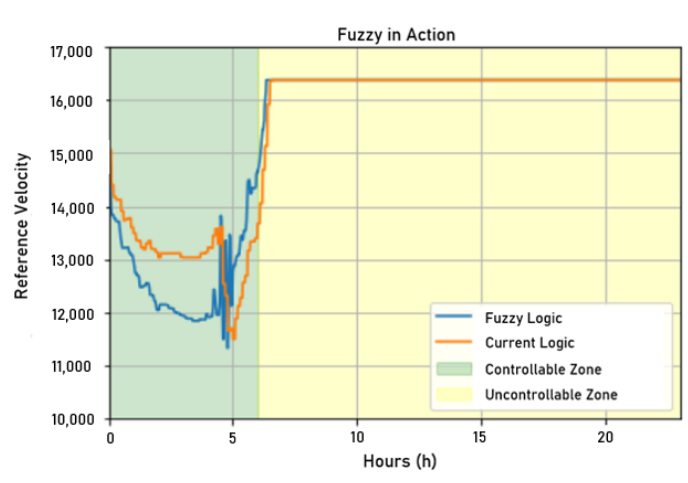
Figure 29. Frequency measured on the second day applying fuzzy control. Source: author.